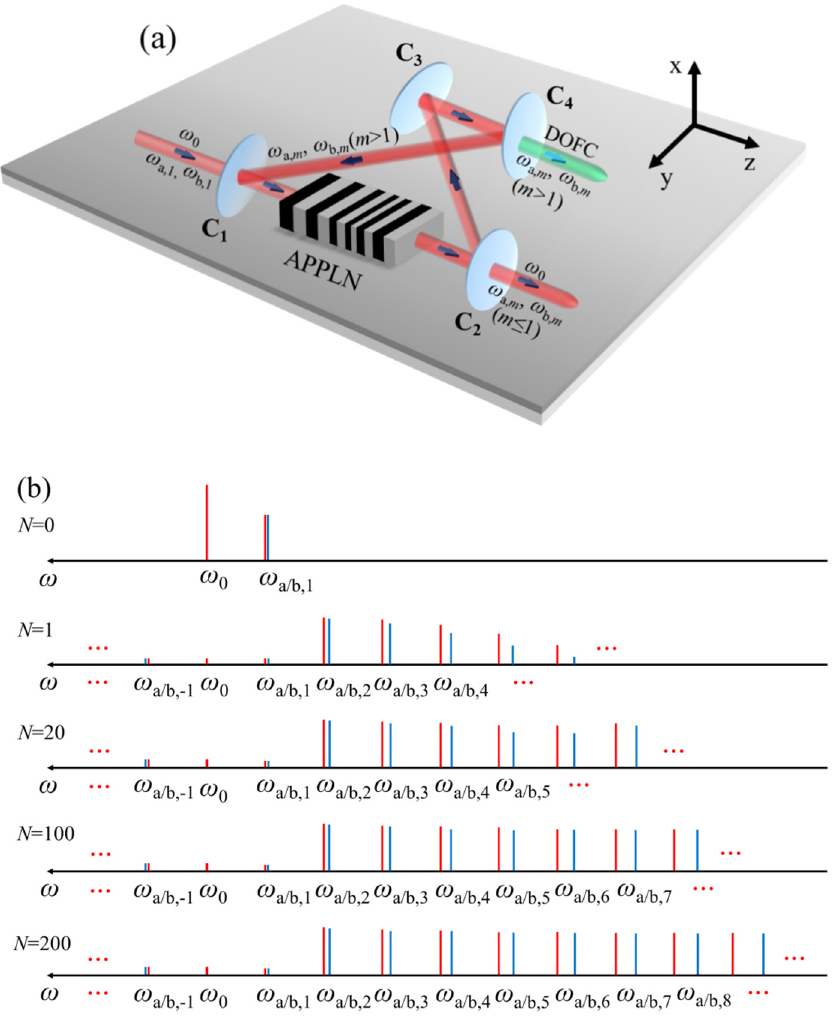
Figure 1. Schematic diagram of DOFC generation by DCDFG. ω 0 and ω a,1 generate a set of cascaded optical waves ω a, m and THz wave ω T1 , respectively. ω 0 and ω b,1 generate a set of cascaded optical waves ω b, m and THz wave ω T2 , respectively. ( a ) Schematic diagram of a bow-tie resonant cavity for cascaded optical Stokes waves; C 1 , C 2 , C 3 , and C 4 are resonant cavity mirrors, and APPLN is a nonlinear optical crystal. ( b ) The interaction of the two sets of ω a,1 and ω b, m generating DOFC; N is the number of oscillations of cascaded optical waves ω a/b, m